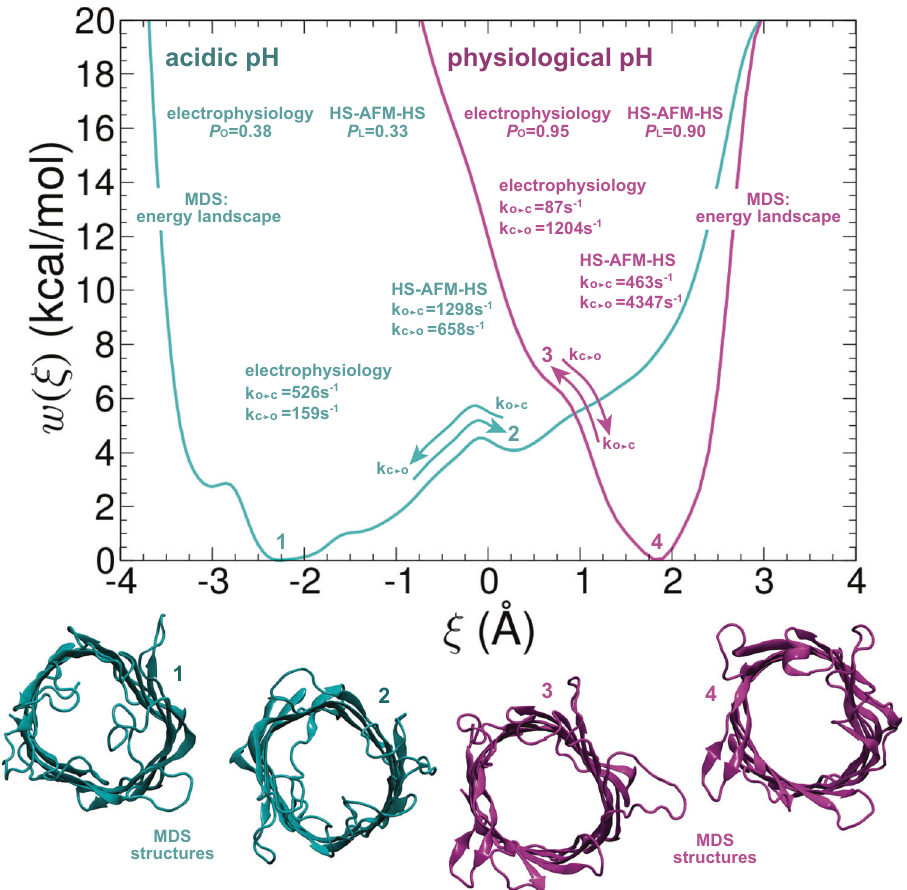
Fig. 4 OmpG free-energy landscapes. Free-energy pro fi les for the gating transition of OmpG at pH 7.5 (magenta curve) and pH 5.6 (cyan curve). Conformations of OmpG for representative basins from the potentials of mean force are depicted: closed (1) and transition state (2) at pH 5.6, open (4) and transition state (3) at pH 7.5. a tightly closed metastable state is found at ξ = − 3.0 Å where loop-1 interactions stabilize loop-6 closure. Open probabilities and rate constants from both electrophysiology and HS-AFM-HS are indicated (see “ Discussion ” ). Rate constants from electrophysiology refer to the slower gating events that represent loop-6